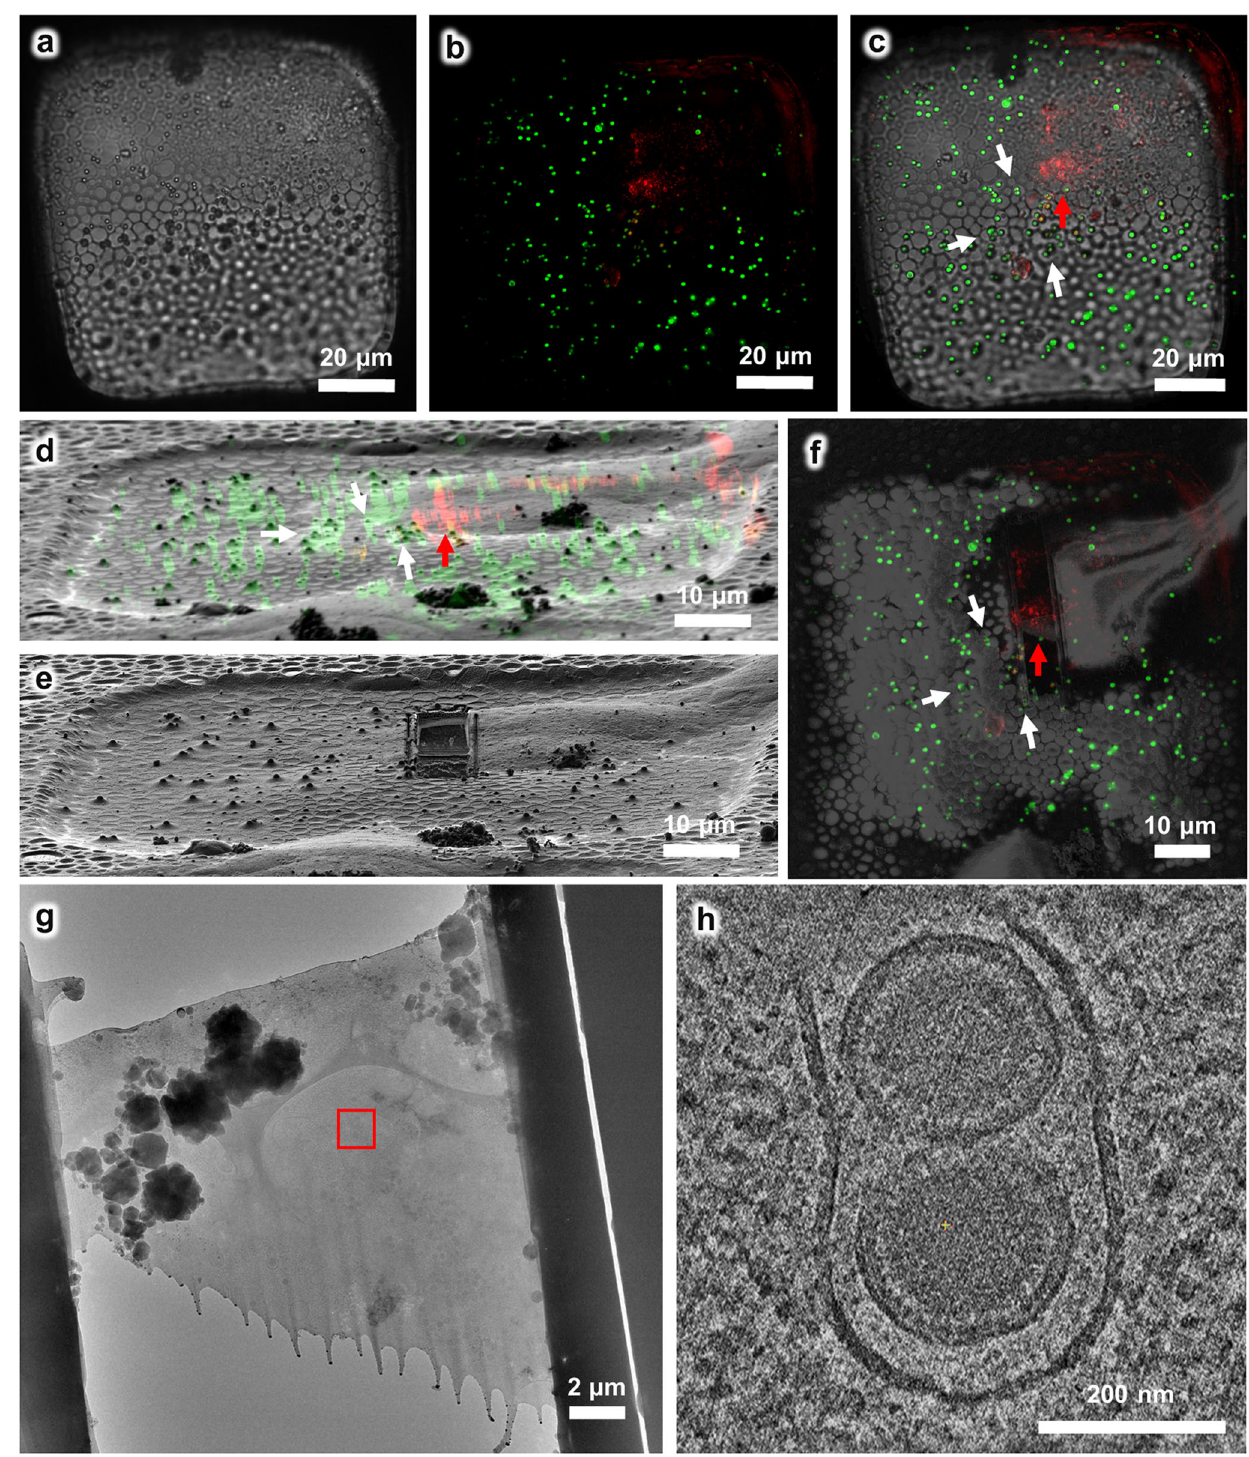
Fig. 4 Using the HOPE-SIM-based cryo-CLEM work fl ow to capture the MHV-68 viral particles in host cells. a Bright- fi eld image of the target square. b The z projection of HOPE-SIM fl uorescent image. Green, fl uorescent microspheres. Red, MHV-68 virus. c The fl uorescent image in ( b ) is merged with the bright- fi eld image in ( a ) to show the location of target signal. d 3D correlation between the cryo-SIM and cryo-FIB images. e Cryo-FIB image of the target square after fabrication. f Cryo-SEM image of the target square after fabrication, which is merged with the z projection of cryo-SIM image in ( b ). g Cryo- EM micrograph (×3,600) of the cryo-lamella in ( f ). The target region marked by the red rectangle is subjected for cryo-ET reconstruction in ( h ) with a magni fi cation of ×64,000, where one slice to the tomogram shows different types of viral particles that are under tegumentation. See Supplementary Data 6 for raw cryo-FIB images of ( d ) and ( e ), raw cryo-SEM image of ( f ), and raw cryo-EM image of ( g